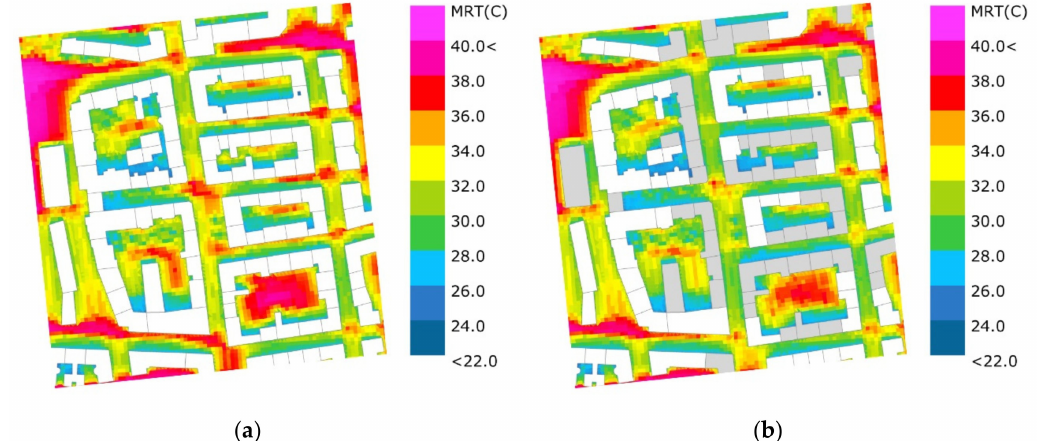
Figure 8. Spatial distribution of mean hourly MRT at ground level: ( a ) base case; ( b ) densification (marked by grey